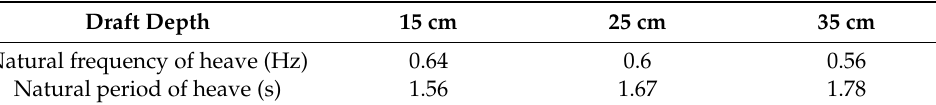
of roll attenuation. gram